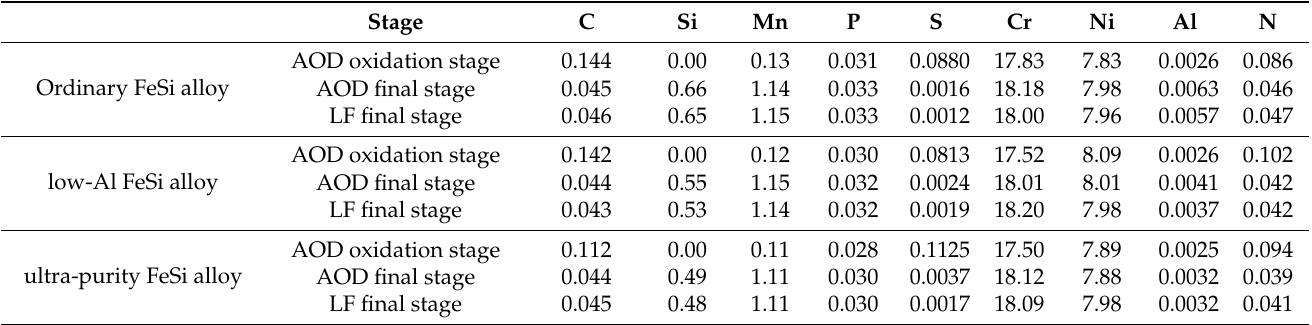
Table 2. Chemical composition of liquid steel (mass%).